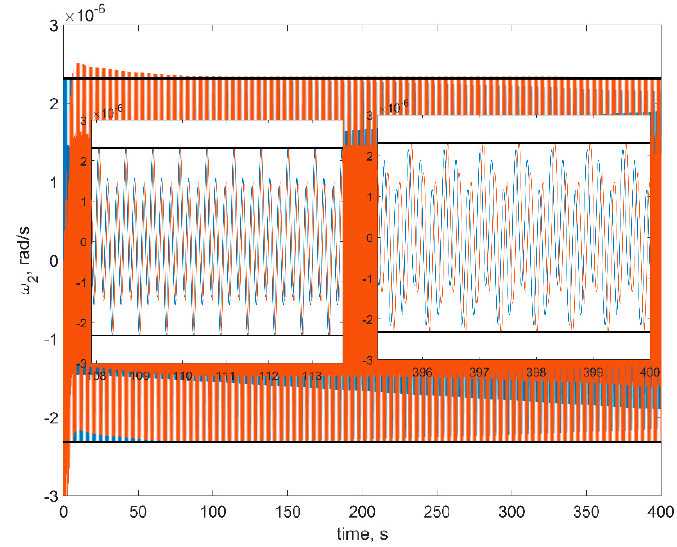
Figure 7. Evolution of ω 2 (red is numerical solution, blue is approximate solution, horizontal lines are the estimations).